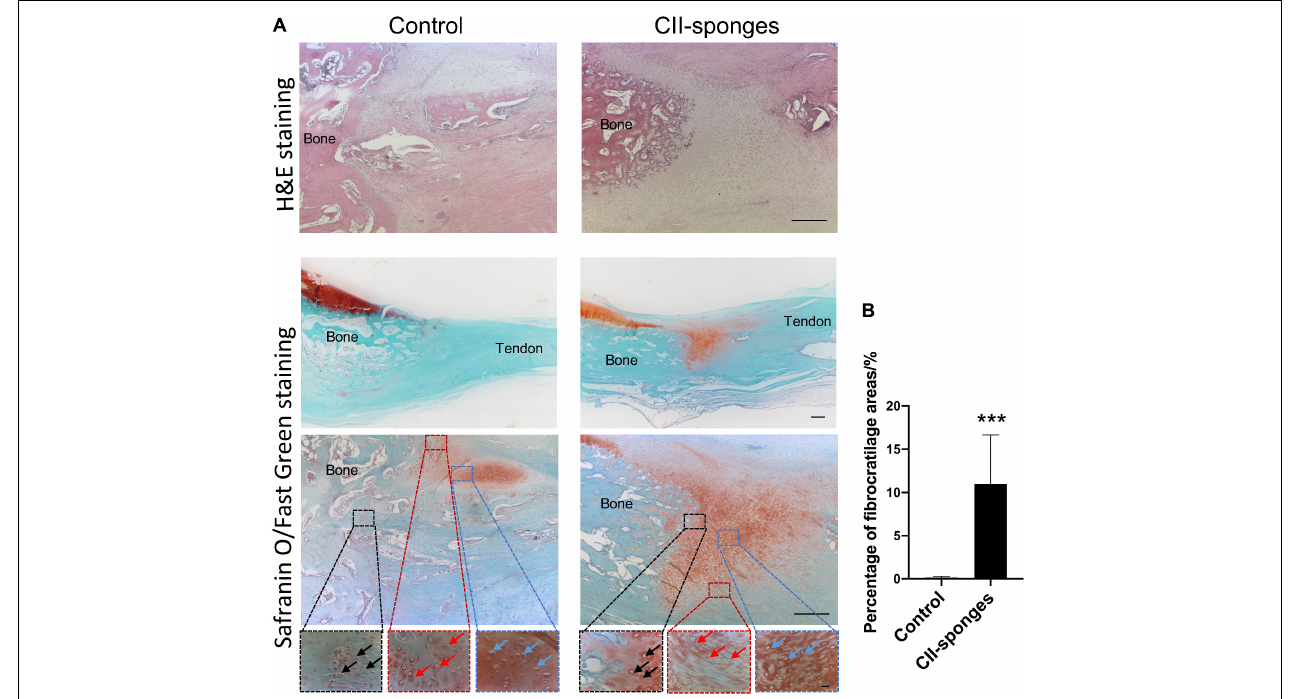
FIGURE 5 | Histological evaluation of the regeneration of fibrocartilage transition zones at BTJ. (A) The regeneration of fibrocartilage transition zones at patellar-patellar tendon junction after partial patellectomy was evaluated by histology staining, H&E, Scale bar 200 µ m. The whole bone tendon junction, the positive proteoglycan expression areas (red) and the morphology of the cells at the BTJ were observed by Safranin O/Fast Green staining, Scale bar 500 µ m (top), Scale bar 200 µ m (middle) and Scale bar 20 µ m (bottom). In order to observe the morphology of the cells at the fibrocartilage zones, three different regions (Dotted boxes) at BTJ were chosen. To be more specific, in the control group the black box indicated the junction between tendon and bone tissues, fibroblast-like cells could be seen (black arrow), the red box suggested the junction between bone and new formed cartilage, chondrocyte-like cells were found (red arrow), and the blue box represented the new formed cartilage, typical chondrocytes could be observed (blue arrow). In the CII-sponge group, the black box indicated the junction between the bone and new formed cartilage, the red box suggested the junction between the tendon and new formed cartilage, and the blue box represented the new formed cartilage. The chondrocytes could be found in all of these three different areas, and indicated by black, red and blue arrows, respectively. (B) Quantification of proteoglycan positive areas in Safranin O staining by Image ProPlus. *** represented as p (cid:53)